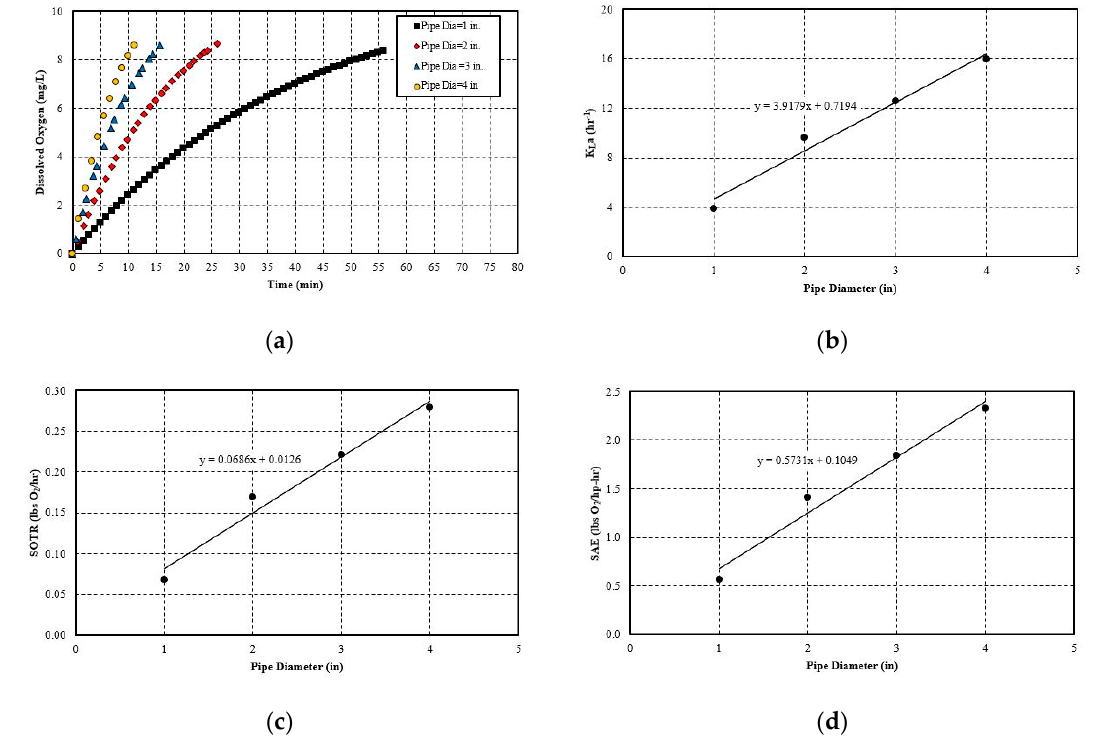
Figure 8. E ff ect of pipe diameter on: ( a ) Dissolved (mg / L) oxygen vs. time (min); ( b ) K L a (h − 1 ); ( c ) SOTR Figure 8. Effect of pipe diameter on: ( a ) Dissolved (mg/L) oxygen vs. time (min); ( b ) K L a (h − 1 ); ( c ) SOTR (lbs O 2 / h); ( d ) SAE (lbs O 2 / (lbs O 2 /h); ( d ) SAE (lbs O 2 /hp-h).